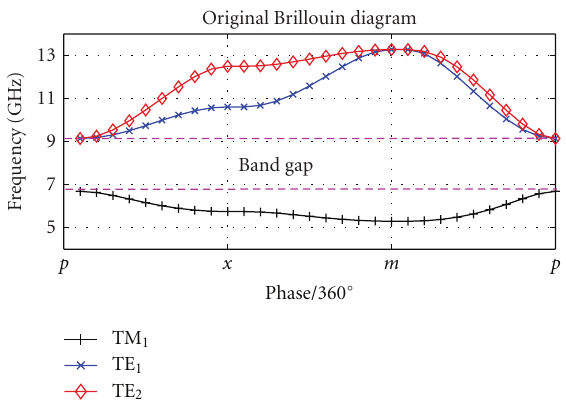
Figure 4: Brillouin diagram for original